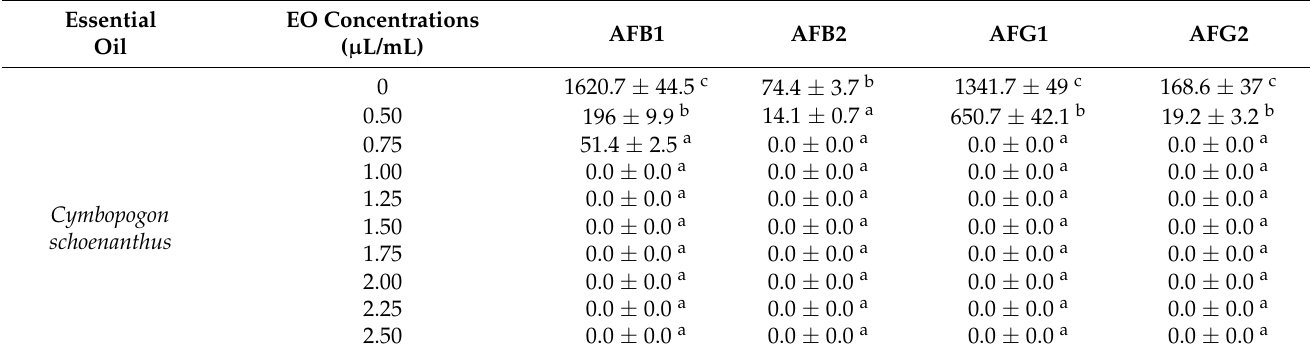
Table 9. Effect of C. schoenanthus oil on aflatoxin production ( µ g/kg) after 7 days exposure to different